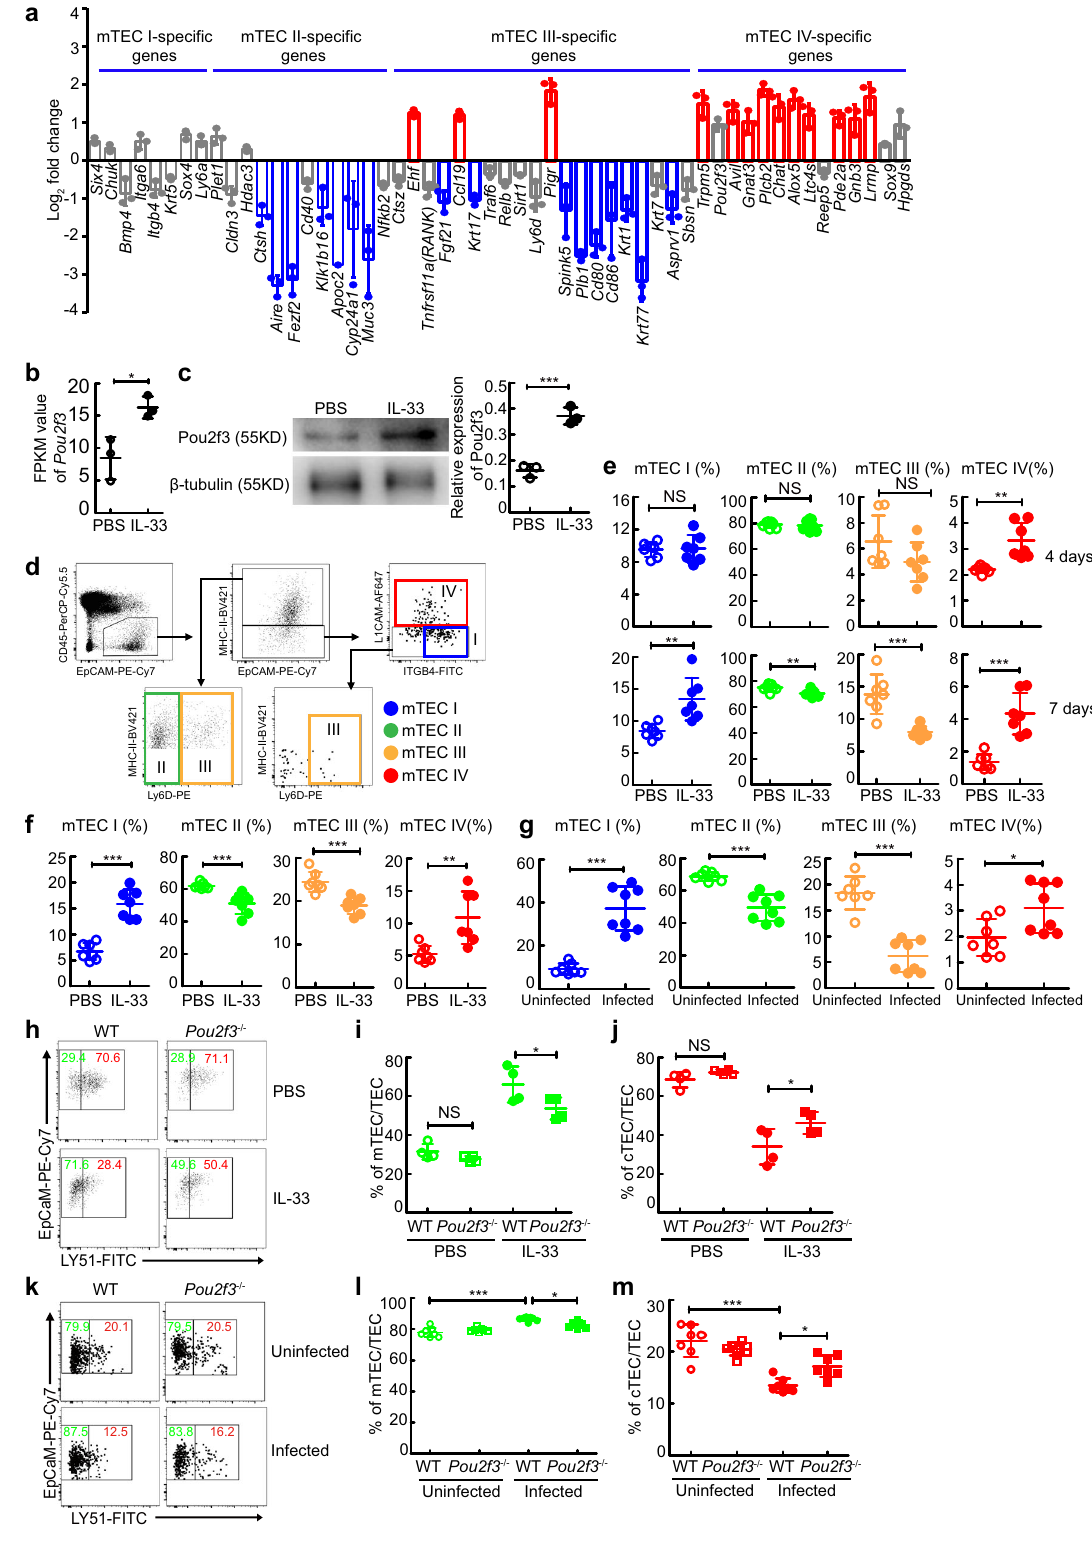
5.0 software. Error bars indicate the s.d. Data were analyzed by a Unpaired two-sided Student ’ s t -test for two-group comparisons and by One-way ANOVA with Tukey ’ s multiple comparisons